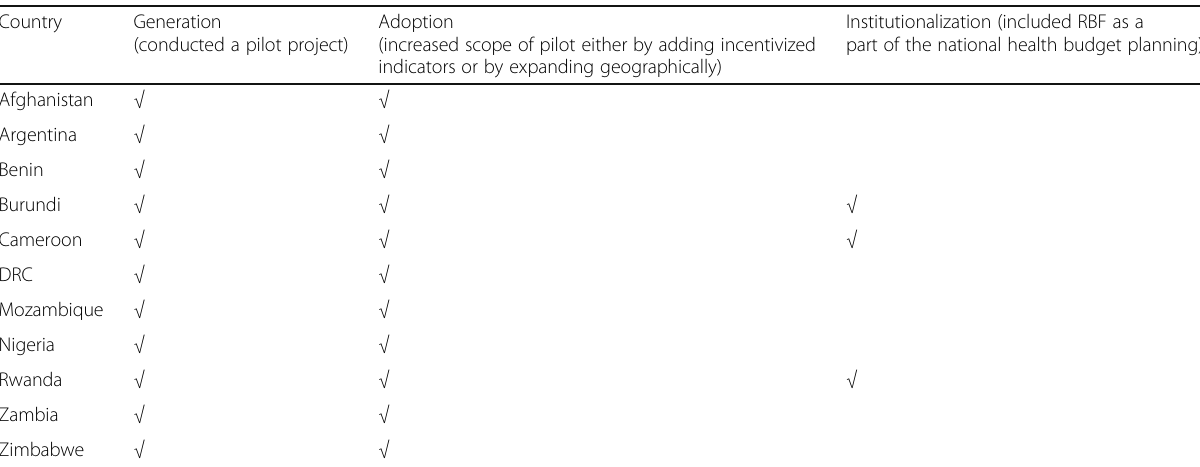
Table 2 RBF scale-up framework